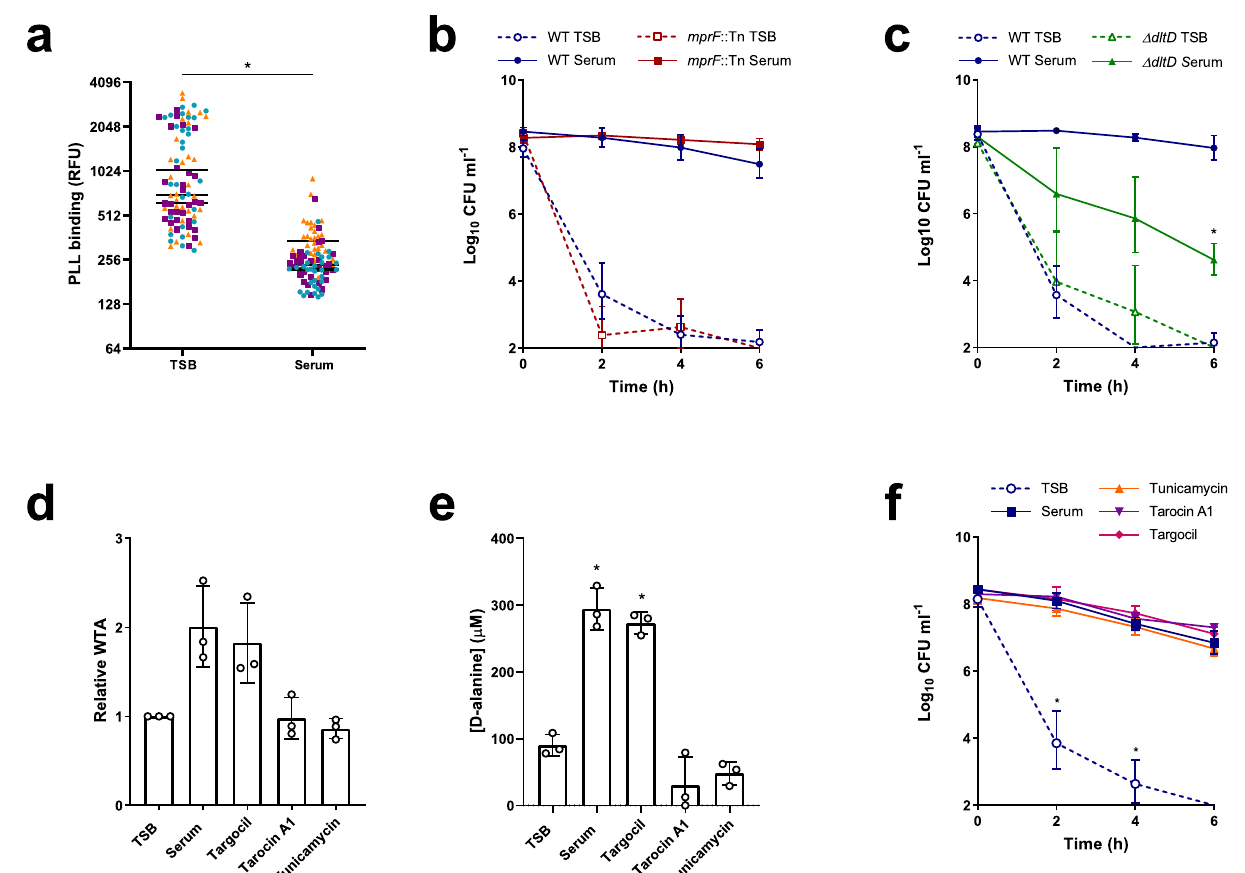
Fig. 4 GraRS-mediated changes in surface charge do not explain serum-induced tolerance. FITC-PLL binding to TSB-grown and serum-adapted cultures S. aureus JE2 WT. Cultures were incubated with 80 μ g ml − 1 FITC-PLL, washed, fi xed and analysed by fl uorescence microscopy ( a ). The fl uorescence of 30 cells per biological replicate (90 cells total per condition) was measured and the mean of each replicate is indicated. Colours represent different biological replicates. Log 10 CFU ml − 1 of TSB-grown and serum-adapted cultures of S. aureus JE2 WT and the mprF ::Tn mutant ( b ) and the Δ dltD mutant ( c ) during